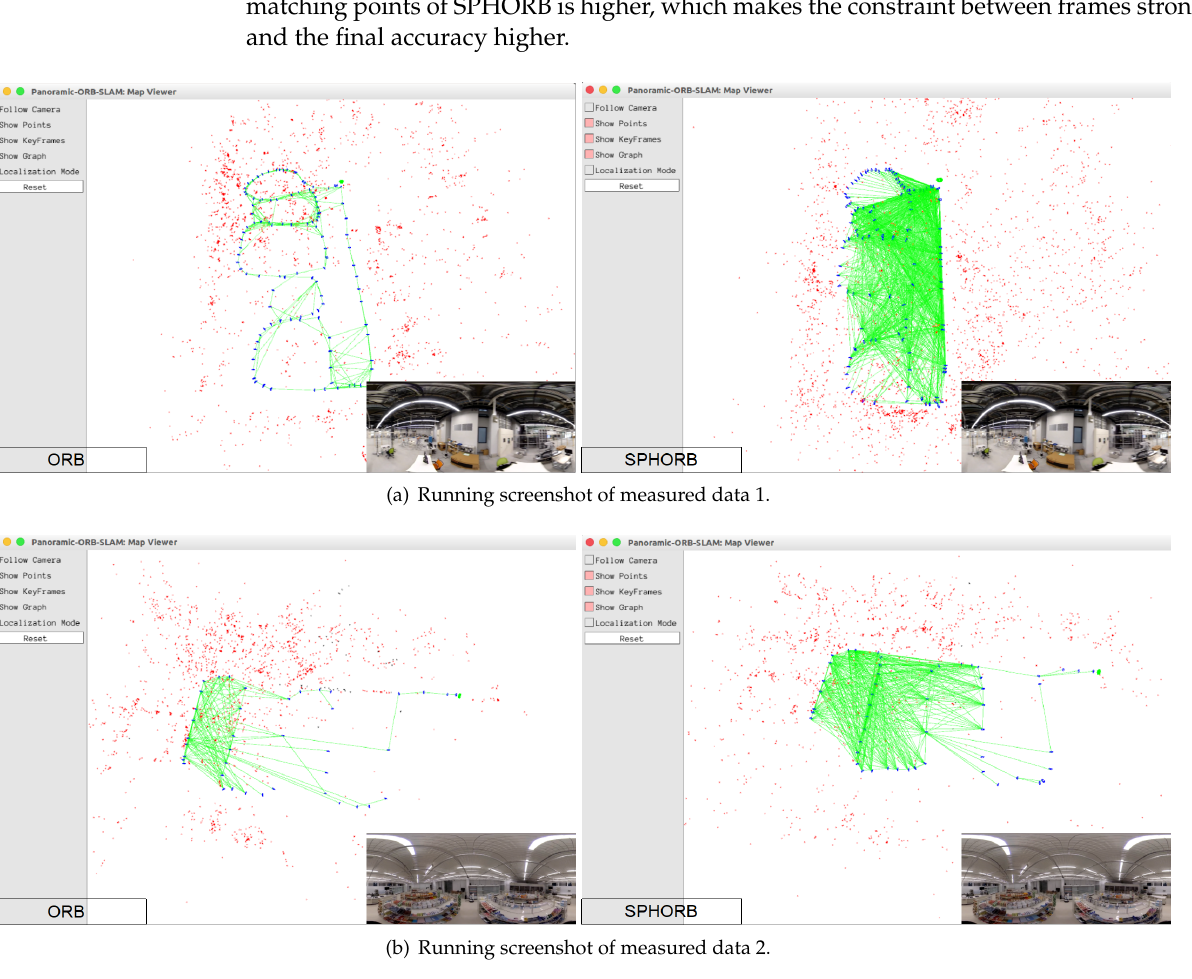
Figure 10. SLAM using ORB and